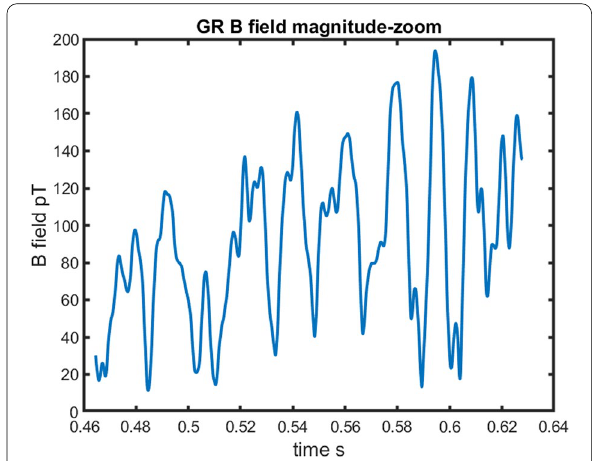
Fig. 2 A plot of wave amplitude Bw in a zoomed segment of the previous event, at z 2000 km. This shows strong sideband activity. = + The output wavefield consists of a series of wave packets of variable length 10–20 ms